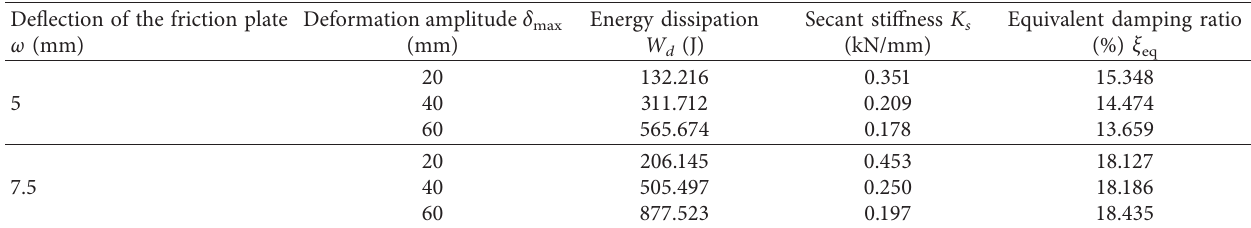
Table 5: Performance parameters under various deformation amplitude (SCVF brace with spring S1). Deflection of the friction plate